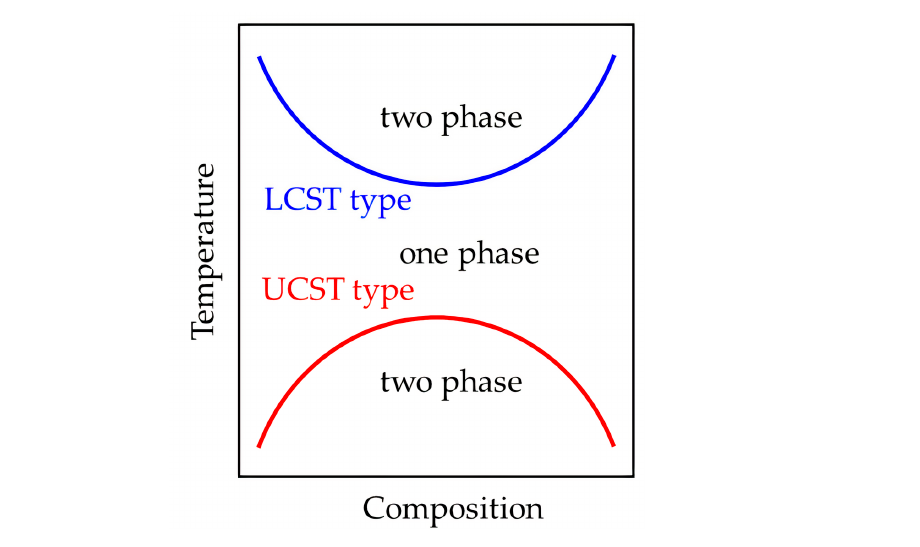
Figure 2. Lower critical solution temperature (LCST) and upper critical solution temperature (UCST) phase transition behaviors of thermo-responsive polymers in solution. Reprinted with permission from Sugeno, K. et al. UCST Type Phase Boundary and Accelerated Crystallization in PTT/PET Blends.Polymers 12(11). Copyright (2020) MDPI [69].